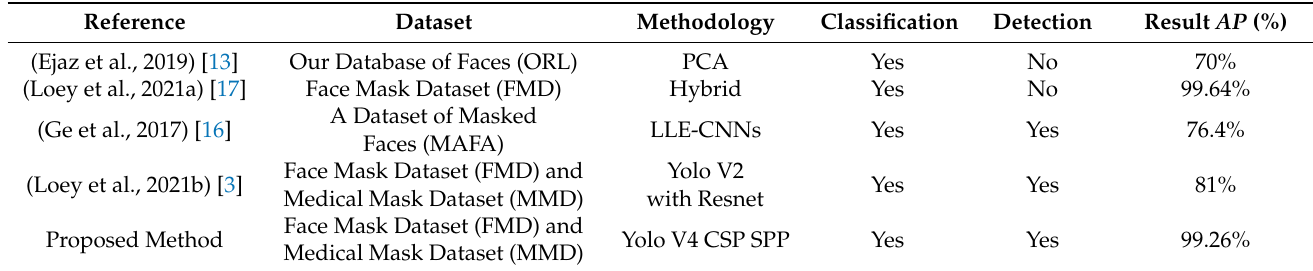
Table 3. Previous research comparison.